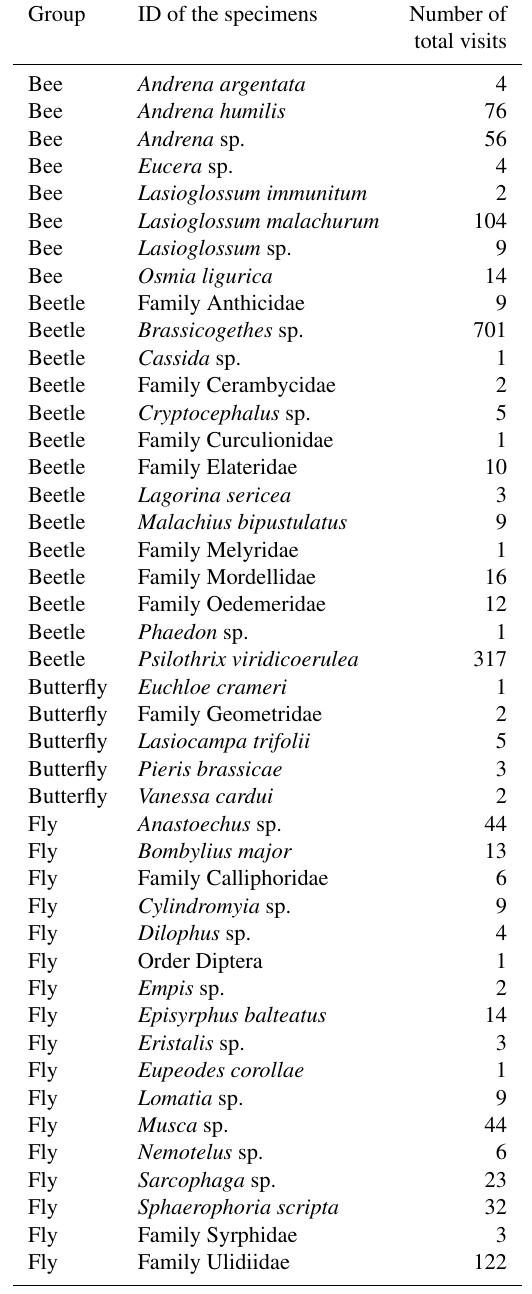
Table A2. Floral visitor frequency. The ID is the most accurate identification of the floral visitors that we have made. Each ID has the associated total number of visits recorded in the field. We clas- sified the ID into four groups of floral visitors: bee, beetle, butterfly and fly.